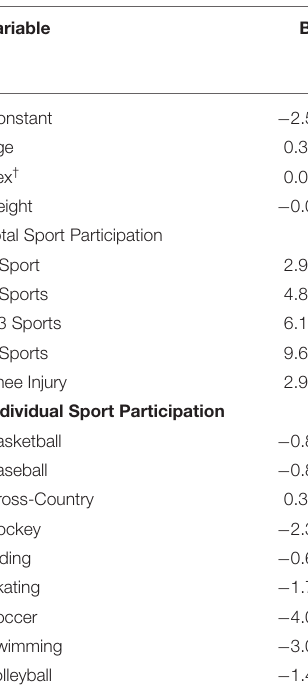
TABLE 3 | Binary logistic regression results.